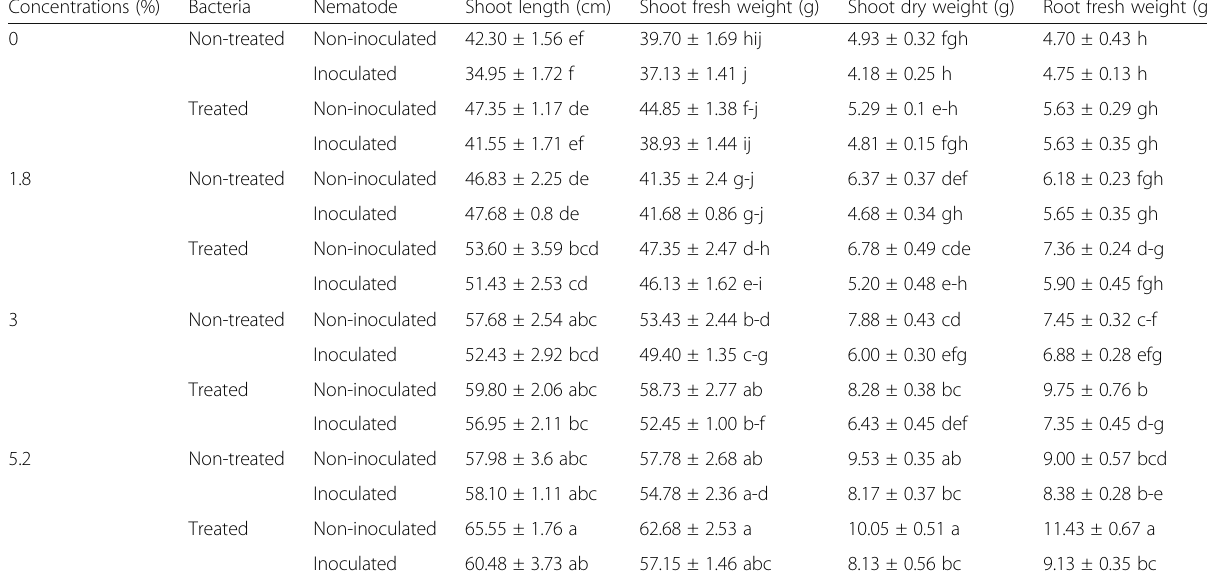
Table 2 Mean plant growth indices of tomato that was either inoculated or non-inoculated with Meloidogyne javanica along with Pseudomonas fluorescens CHA0 and different concentrations of Myrtus communis treated in trials I and II Concentrations (%)